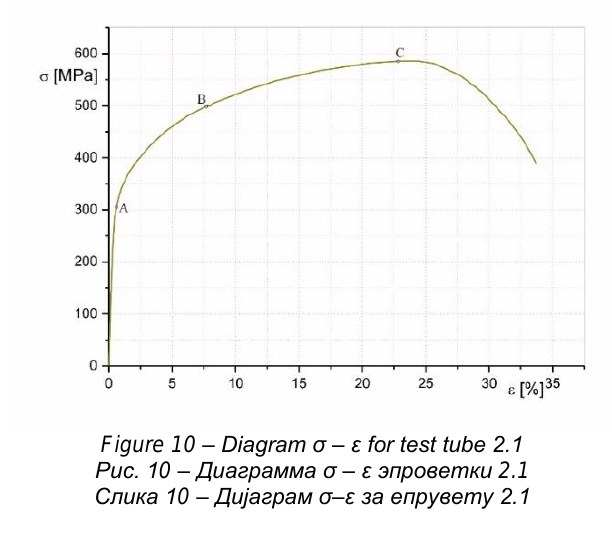
Figure 10 – Diagram σ – ε for test tube 2.1 Рис. 10 – Диаграмма σ – ε эпроветки 2.1